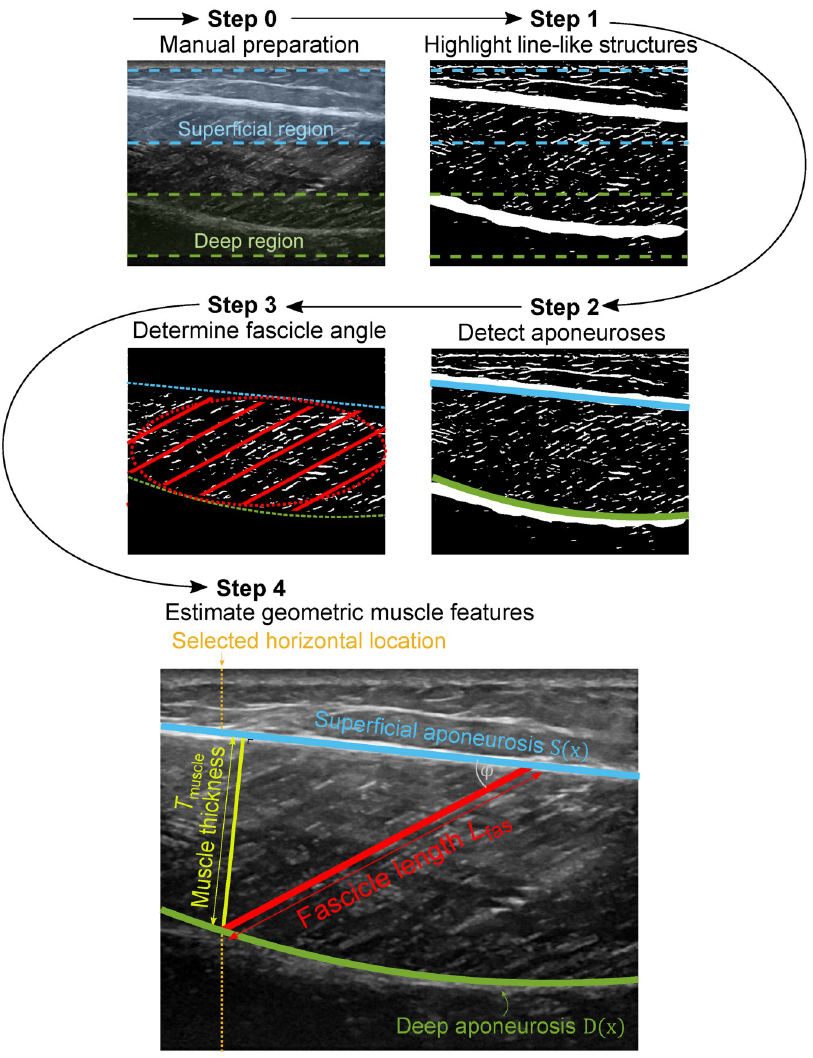
Fig 1. Summary of steps in processing of ultrasound images. Raw images undergo manual preparation to select regions (step 0), and image filtering to highlight line-like structures (step 1). Aponeuroses are detected from the filtered images using either object- or line detection procedures (step 2). An ellipsoid region between detected aponeuroses is used to determine fascicle angle with a line detection procedure (step 3). Geometric muscle features are estimated from detected aponeuroses and determined fascicle angle (step 4). Pennation angle φ is defined as the difference between fascicle angle and superficial aponeurosis angle. Muscle thickness T muscle is defined as the perpendicular distance from the deep aponeurosis to the detected superficial aponeurosis. Fascicle length L fas is calculated from pennation angle φ and muscle thickness T muscle using trigonometry. Muscle thickness T muscle and therefore fascicle length L fas can be evaluated at any horizontal location selected by the user (dotted yellow